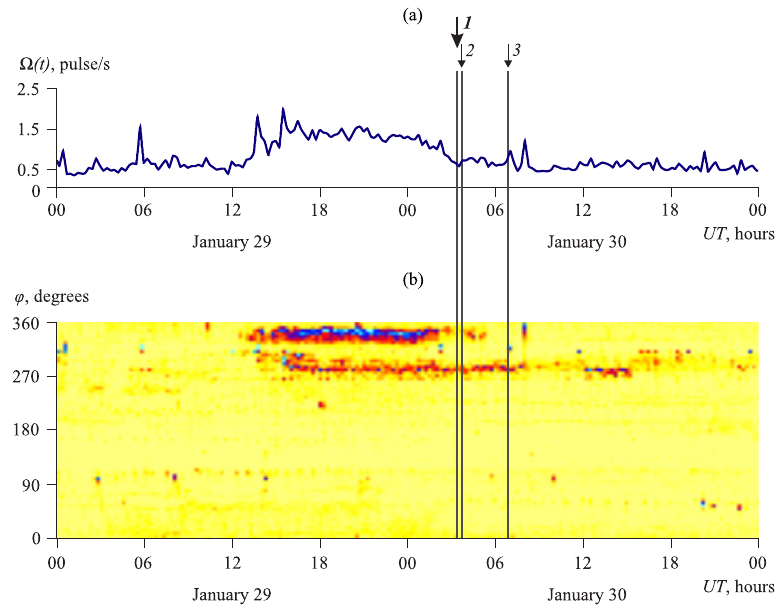
Figure 16. Period before and after the earthquake with M l = 7.1 (1) and its aftershocks (2, 3) occurred on 30 January 2016: ( a ) acoustic activity Ω ( t ) , ( b ) its azimuthal distribution D ( ϕ , t ) . The color shows the number of detected pulses ascending from white to